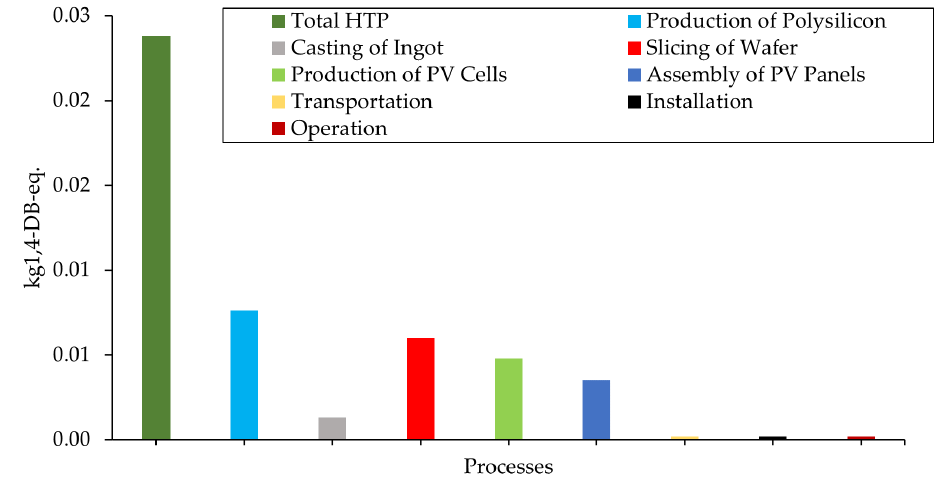
Figure 11. Human toxicity potential .